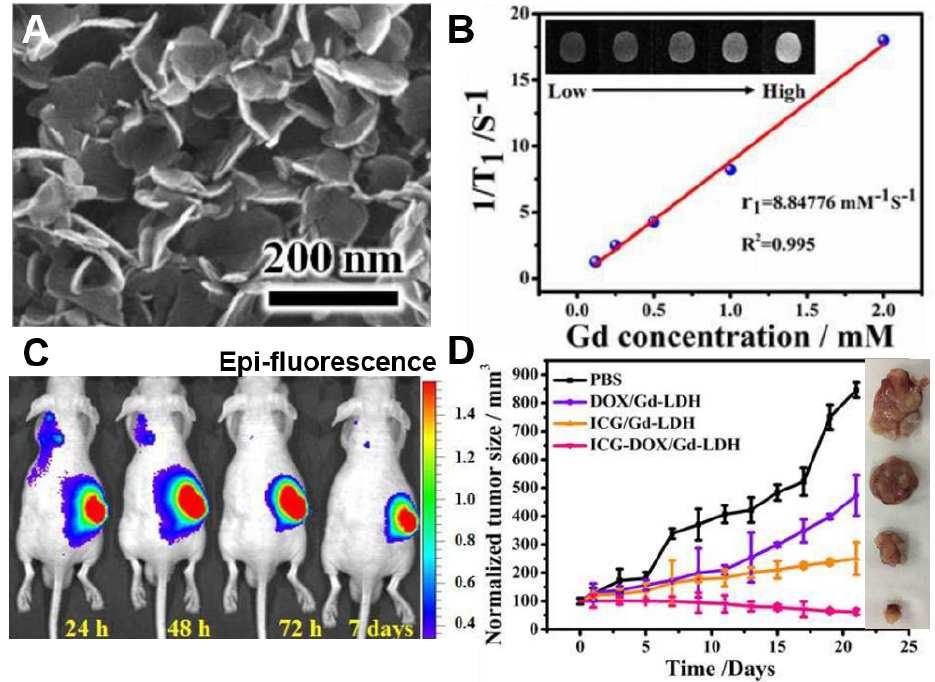
Figure 9. ( A ) SEM image of Gd-LDH/ICG-DOX, ( B ) analysis of relaxation rate 1/T 1 vs. Gd concentration and corresponding T 1 -weighted MR images (inset), ( C ) in vivo fluorescence imaging Hela tumor bearing nude mice at 24, 48, 72 h, and seven days after intratumor injection of Gd-LDH/ICG-DOX, ( D ) the tumor growth curves under different treatments and photo images of excised Hela tumors collected at 20 days after corresponding treatment, reproduced from [30], with permission from the Royal Society of Chemistry, 2017.